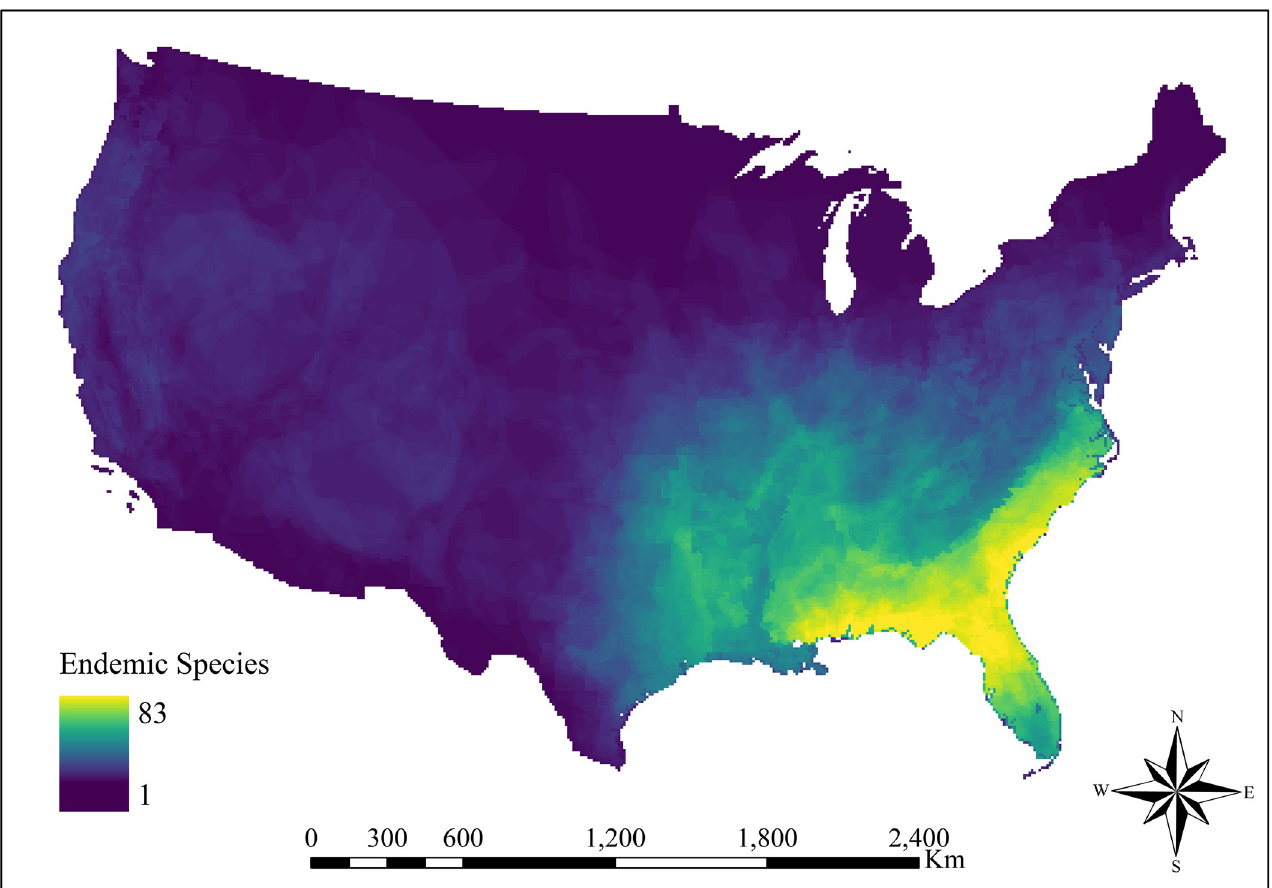
Fig 4. Cumulative range map of endemic amphibian, bird, mammal, and reptile species in the conterminous U.S. Most endemic species within the conterminous United States were within the southeastern U.S. The western U.S. had ten or less overlapping endemic species. Endemic species were defined as a species in which the species entire distirbution is within the conterminous